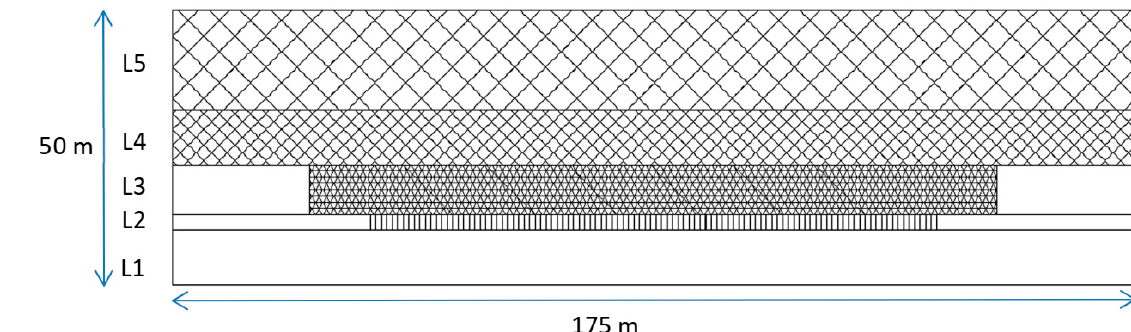
Figure 5. Rock mass model with the system of discontinuities.